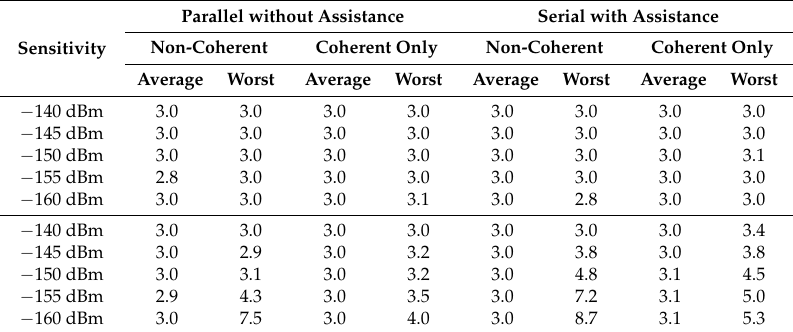
Table 19. Ratio of complexity (product of processing time ratio and memory ratio) between the E1 signal with a sampling frequency of 6.144 MHz and the E1 signal with a sampling frequency of 4.096 MHz. Top rows do not consider the input memory, while bottom rows consider the input memory.